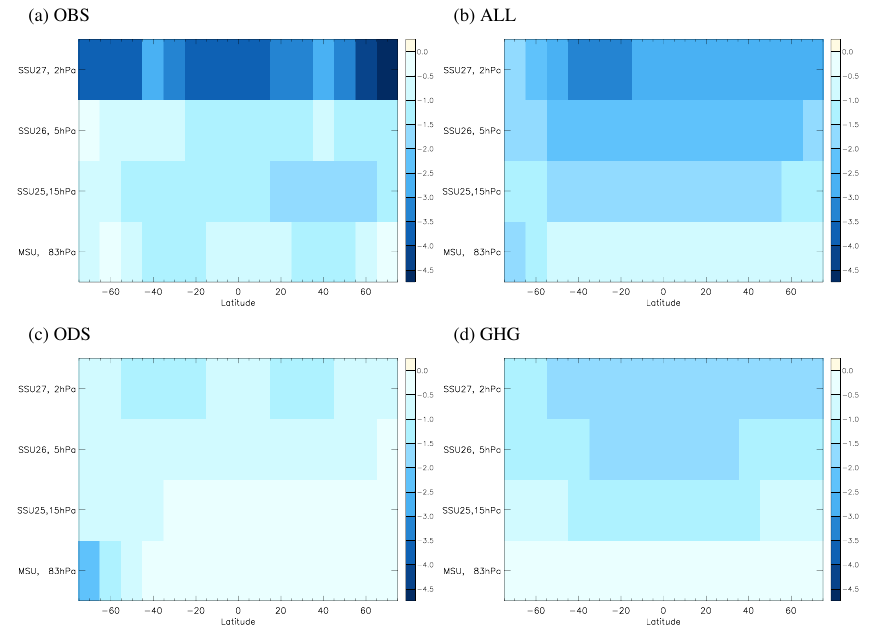
Fig. 7. Zonal mean linear least-squares trends in stratospheric temperature (K over the period 1979–2005) in SSU and MSU observations (Randel et al., 2009) (a) , and simulated in response to combined anthropogenic and natural forcings (b) , ODS changes (c) , and GHG changes (d) . The name of each channel and the approximate pressure of the maximum in its weighting function are shown on the